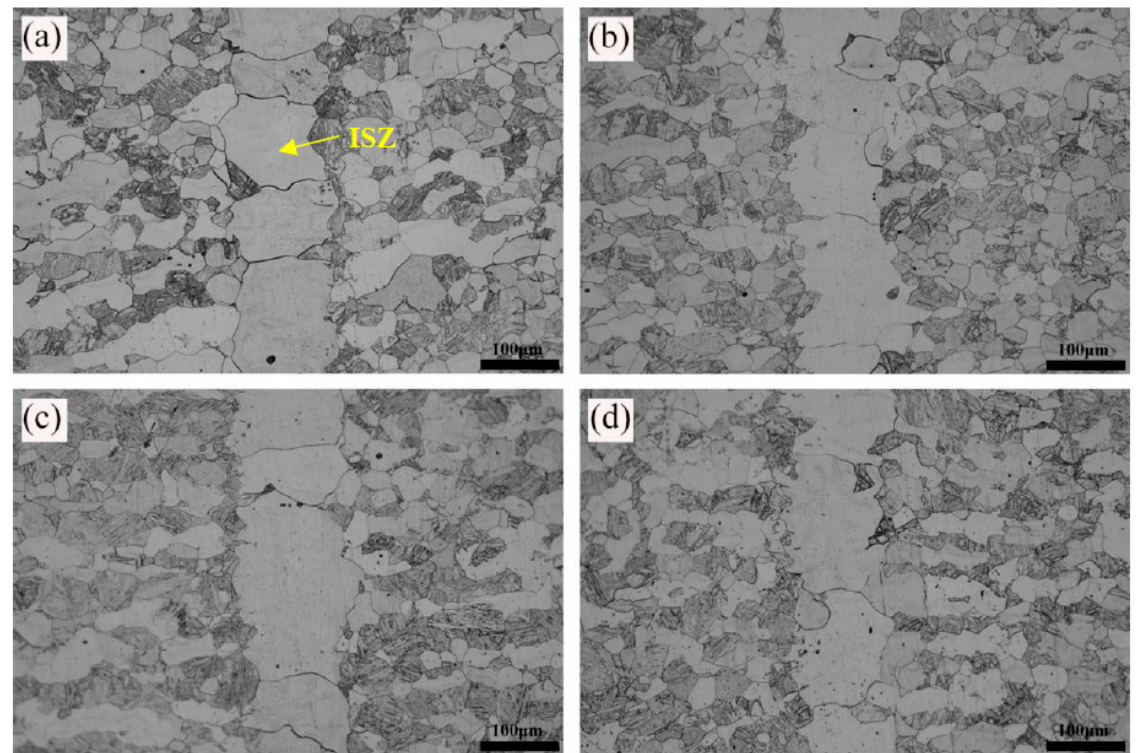
Figure 2. Microstructures of TLP joints after aging at 550 °C with different aging times: ( a ) 5 h, ( b ) 20 h, ( c ) 100 h, and ( d ) 500 h.